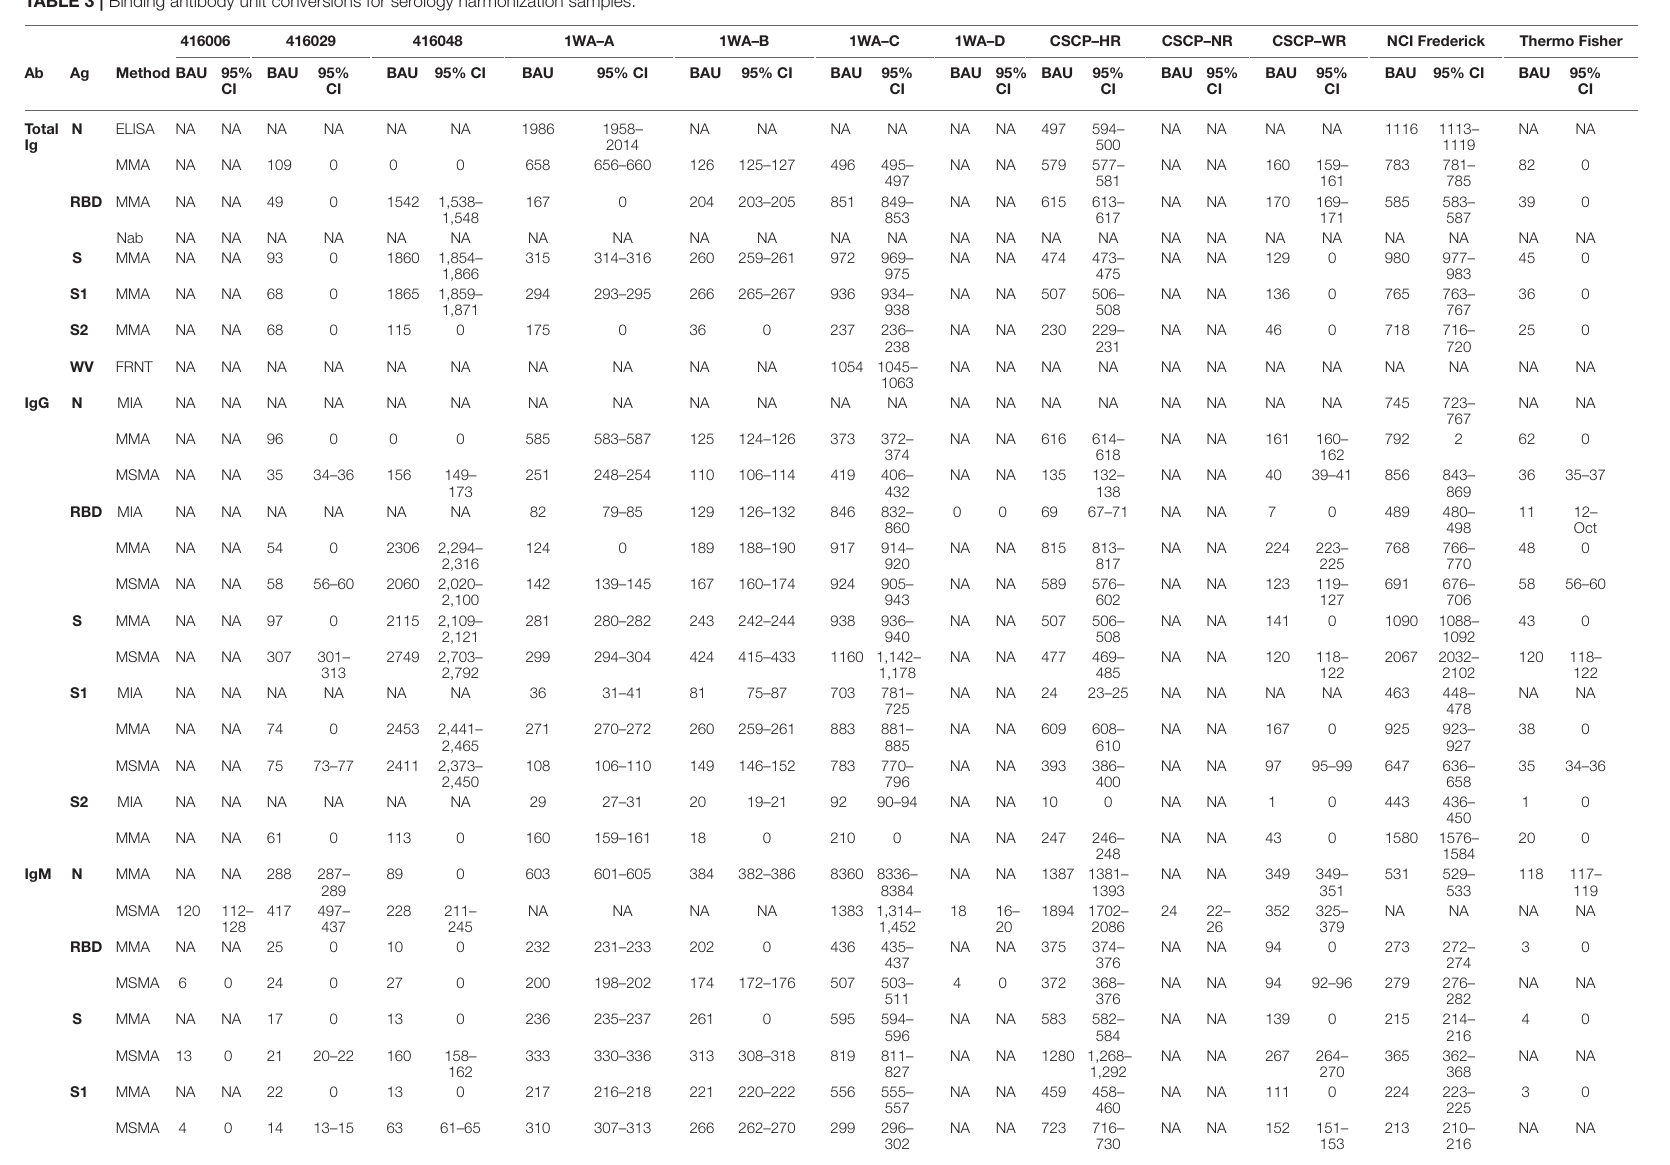
TABLE 3 | Binding antibody unit conversions for serology harmonization